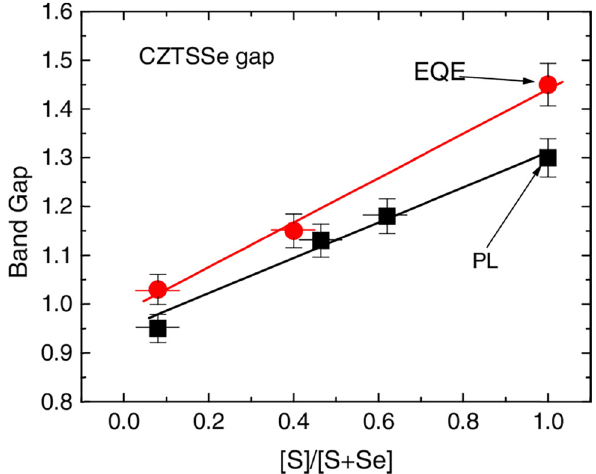
Figure 3: E g s of CZTSSe as a function of ( S ) / ( S + Se ) derived from photoluminescence ( PL ) ( solid squares ) and from external quantum e ffi ciency EQE ( solid circles ) . Reprinted with permission from ref. [ 50 ] . ©2011 AIP Publishing.